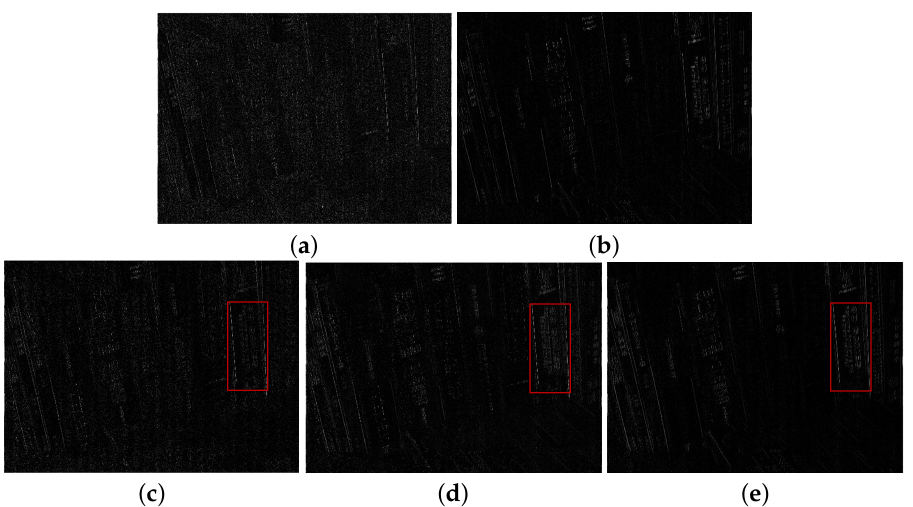
Figure 4. Fusion and denoising results of the high-pass bands in Books . ( a ) RGB image. ( b ) NIR image. ( c ) First iteration. ( d ) Third iteration. ( e ) Tenth iteration.